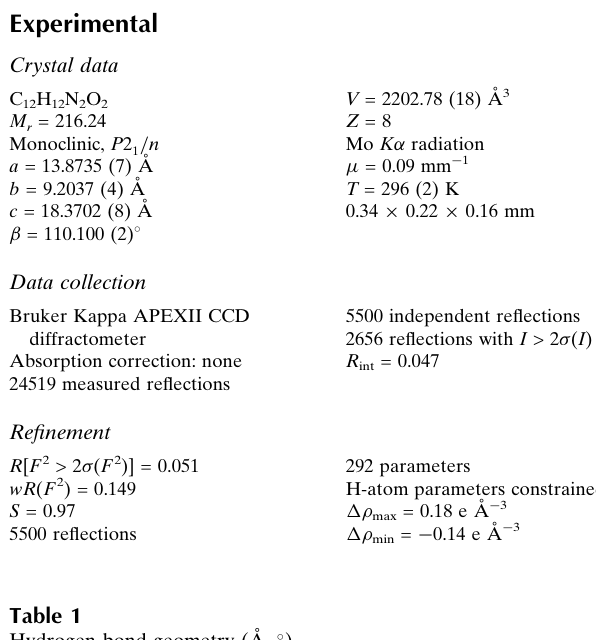
Hydrogen-bond geometry (A˚ , (cid:1)